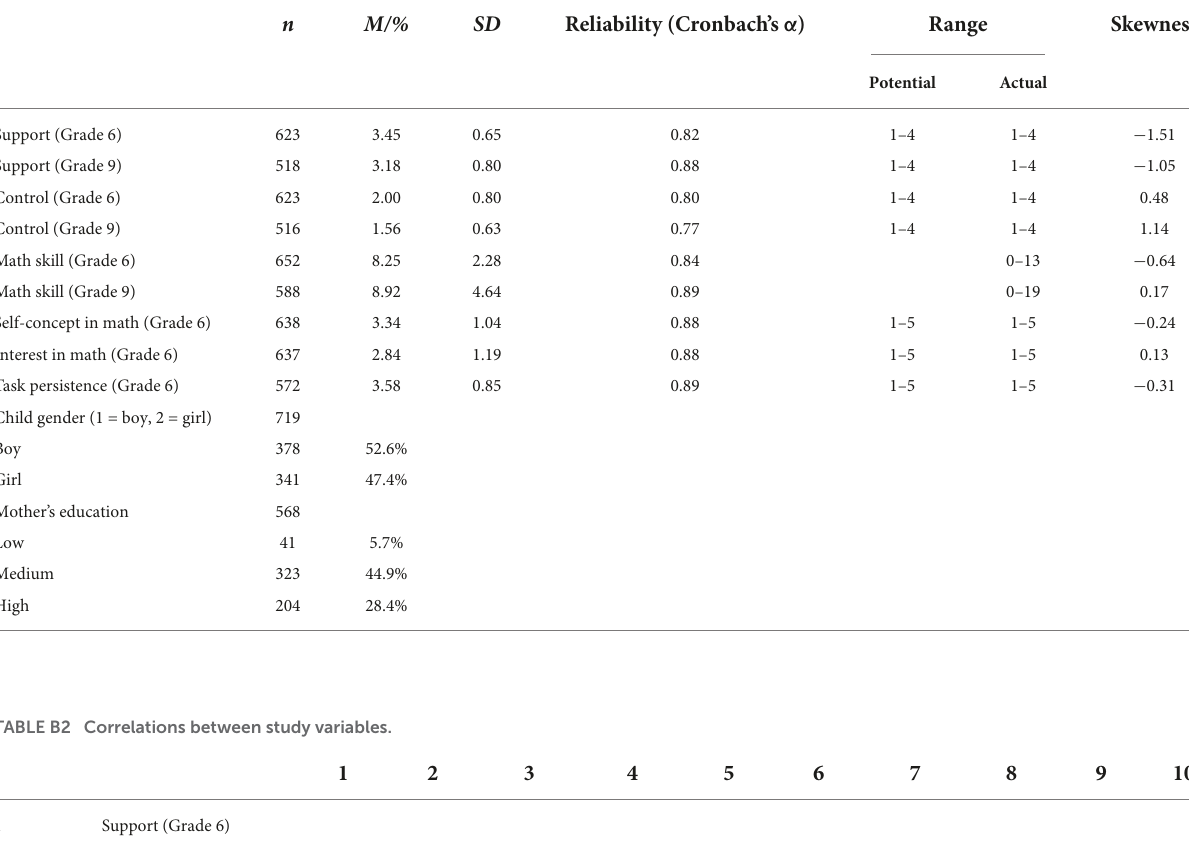
TABLE B1 Psychometric properties of all study variables.